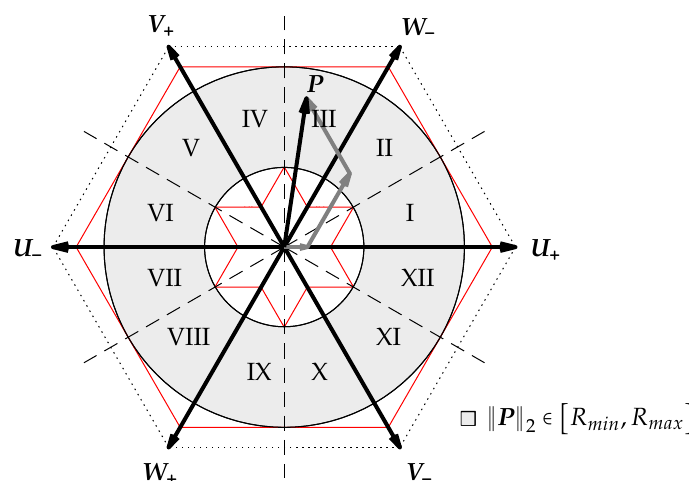
Figure 10. 3-Active HDR SVM: The desired space vector P is built with three fundamental space vectors (involving a space vector from each phase) and one zero space vector ( t INF = 0.1).